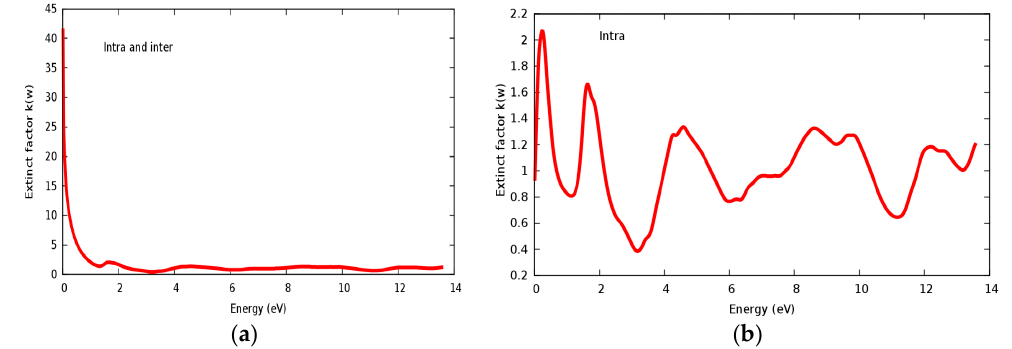
Figure 12. ( a ) Extinct factor k ( ω ) within inter and intra; ( b ) Extinct factor k ( ω ) within intra for SrRhO 3 compound.